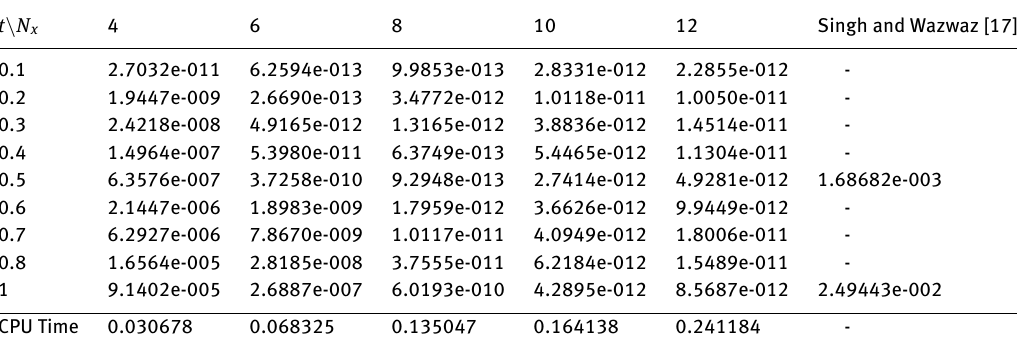
Table 1: Maximum errors E N for example 1 using N t = 10 and m = s = 3